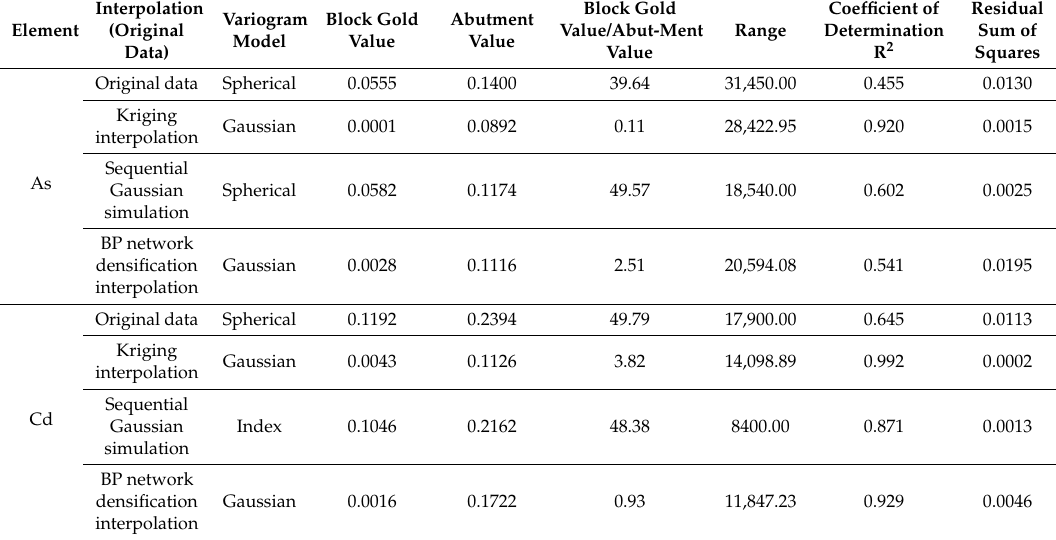
Table 3. Semivariogram model and parameters of the estimation results by different interpolation methods. Interpolation Element (Original